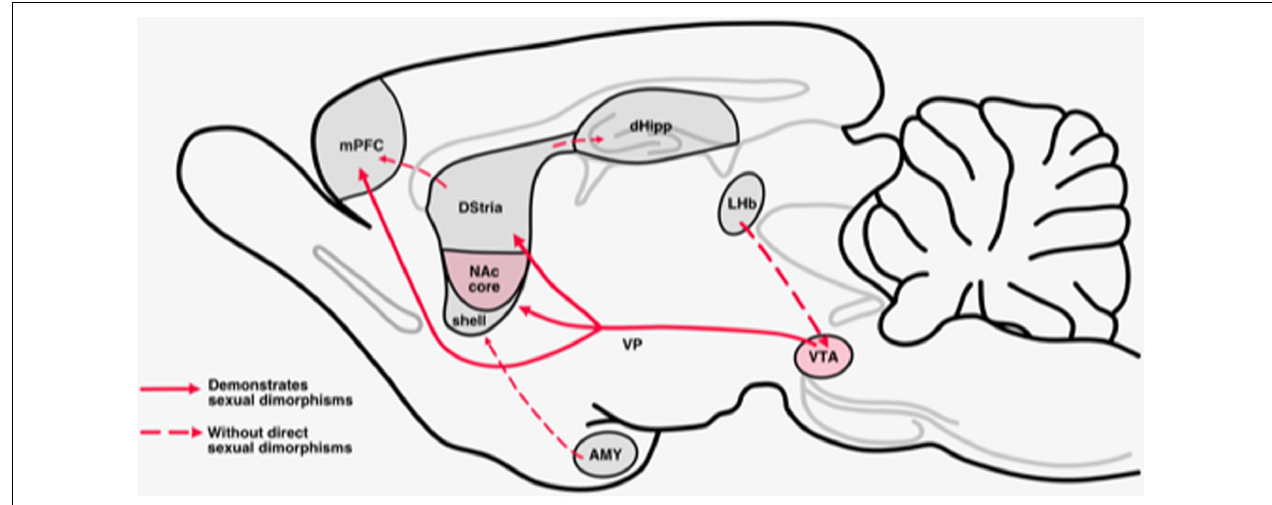
FIGURE 1 | Mesolimbic reward circuits. The mesolimbic pathway originates with dopaminergic cell bodies in the VTA. Dopamine cell bodies in the VTA are tonically inhibited by GABAergic neurons in the VTA. This pathway projects primarily to the NAc, dorsal striatum (Dstria), and medial prefrontal cortex (mPFC). Sexual dimorphisms that are established for projections within these pathways and are delineated with a solid